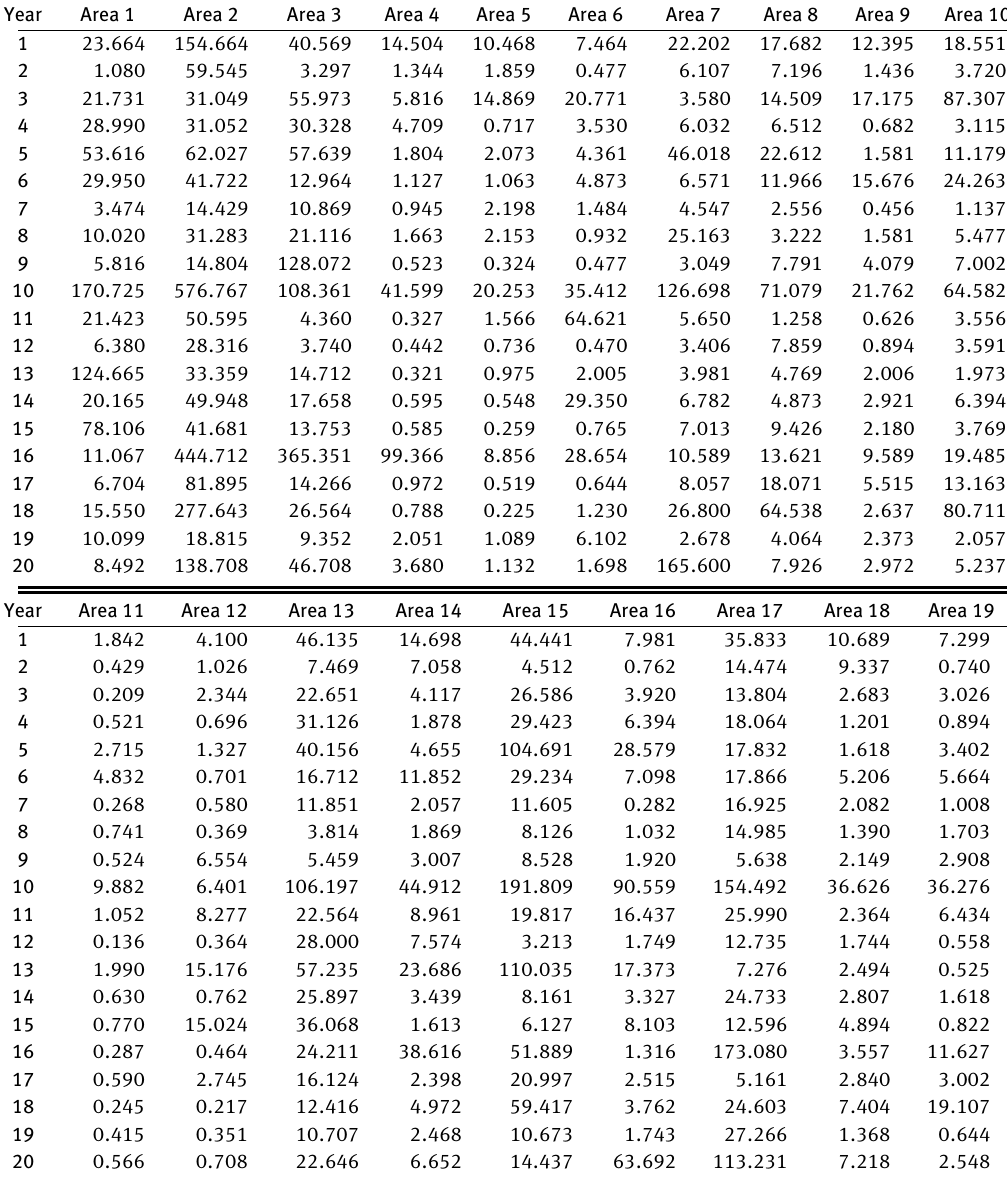
Table 4: Insurance losses from a Nat Cat portfolio in central Europe.